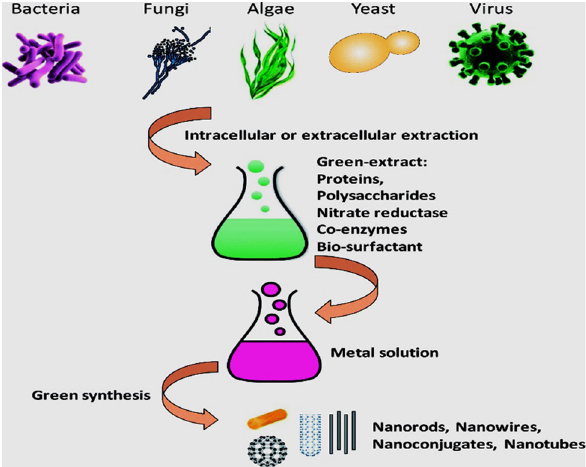
Figure 3: Illustration of metal nanoparticles synthesis procedure from microorganisms [ 86 ] .